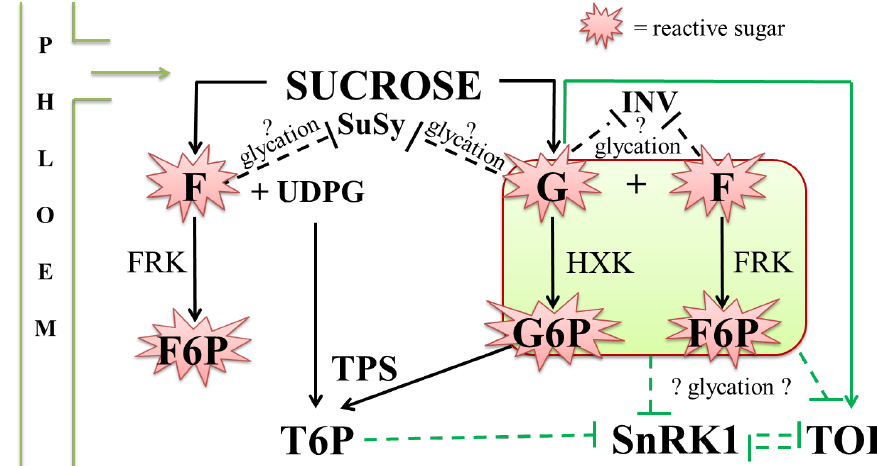
Figure 4. Hypothetical model for interplay between glycation and sugar metabolism and signalling in plants. F, fructose; G, glucose; F6P, fructose-6-phosphate; G6P, glucose-6-phosphate; SuSy, sucrose synthase; INV, invertases; T6P, trehalose-6-phosphate; SnRK1, SNF1-related protein kinase 1; TOR, target of rapamycin kinase; UDPG, uridine diphosphate glucose; HXK, hexokinase; FRK, fructokinase; TPS, trehalose-6-phosphate synthase. Green arrows represent sugar signaling pathways and black arrows represent sugar metabolism. Arrows and T-bars represent stimulatory and inhibitory effects, respectively.